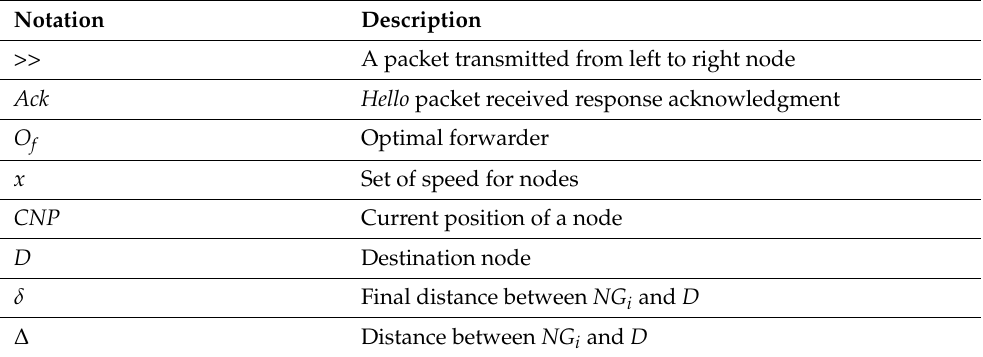
Table 2. List of